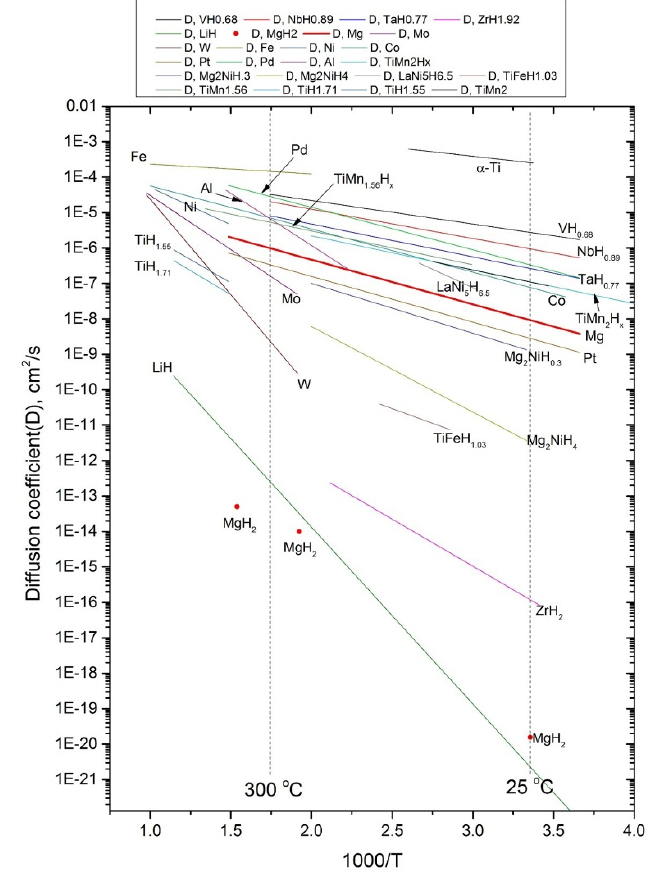
Figure 4. Hydrogen diffusion coefficients in different metals and hydrides. (Reprinted from ref. [51]. Copyright 2015 Chengshang Zhou).